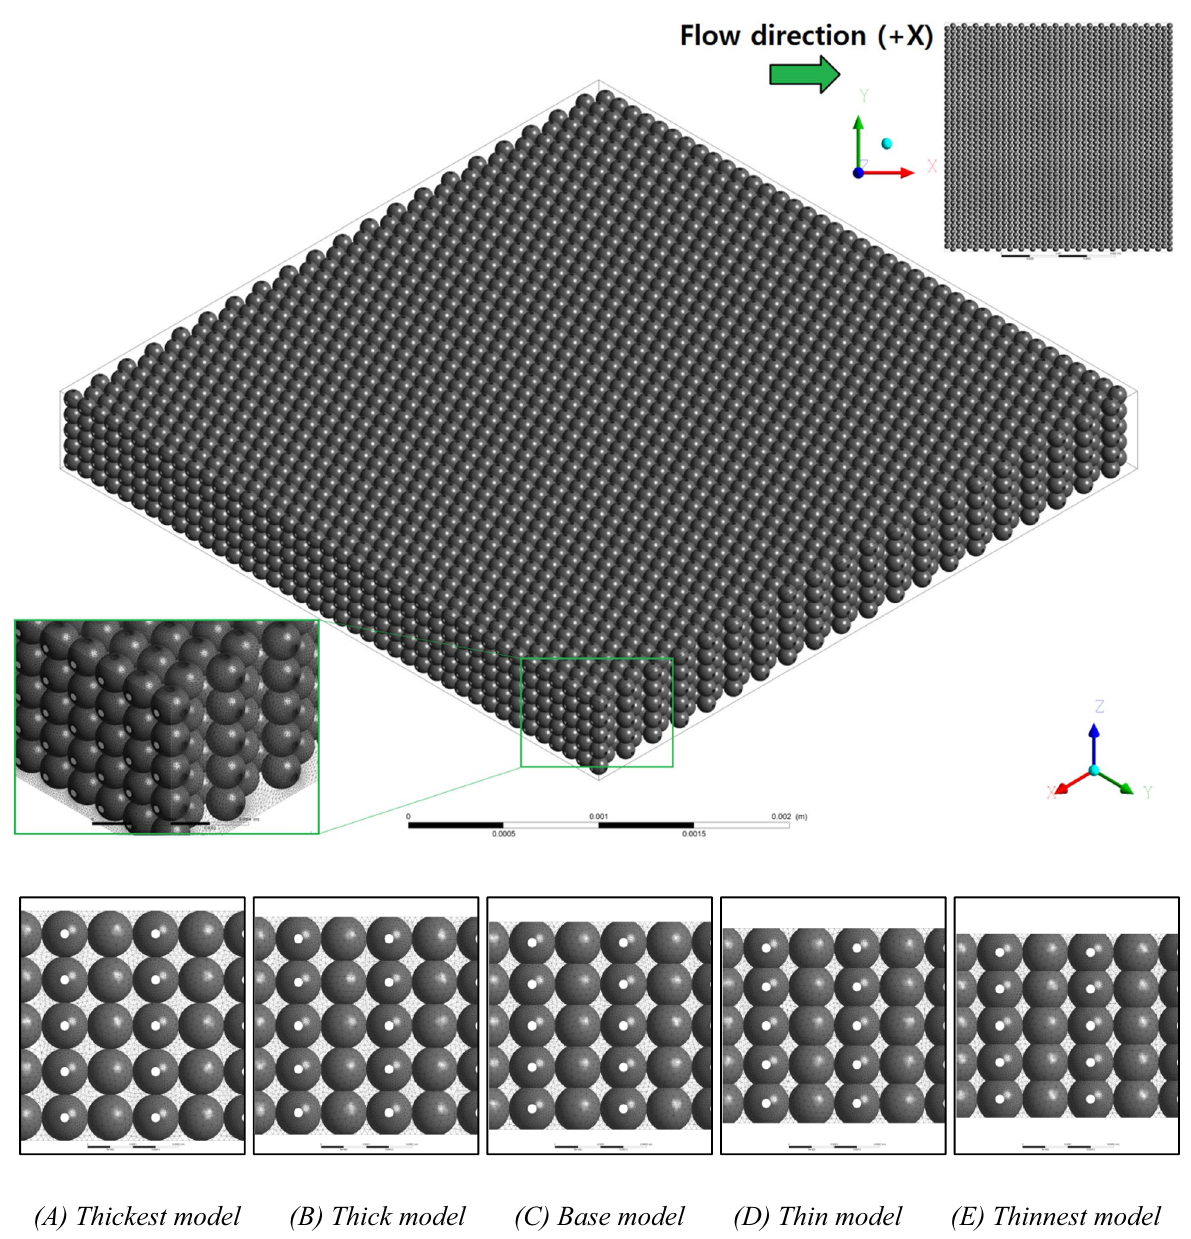
Figure 7. Geometry of the (A) thickest model of the mono-size pack model (upper figure) and geometry comparisons in the aperture reductions of five models (A–E) in the X–Z plane; total of 7900 microbeads with 0.102 mm uniform diameter (the original diameter of the spheres, excluding the cuts by plates and overlapping with neighbouring